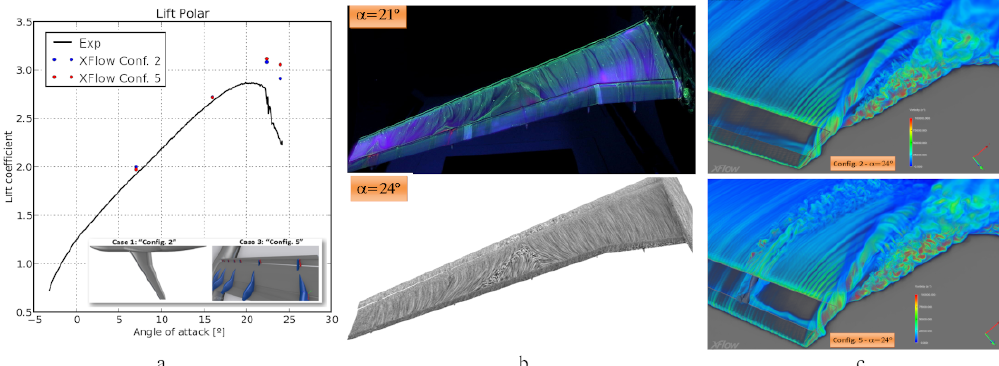
Figure 11. High-Lift aircraft configuration: ( a ) Lift coefficients on conf. 2 and conf. 5 for Re = 15.1 · 10 6 ( b ) Flow pattern comparison between XFlow ( bottom ) and wind-tunnel oil flow images ( top ) for the stall region with conf. 5. ( c ) Volumetric rendering of vorticity comparison between Conf. 2 ( top ) and Conf. 5 ( bottom ) at 24 deg [6].